Question: Write a descriptive caption for this figure.
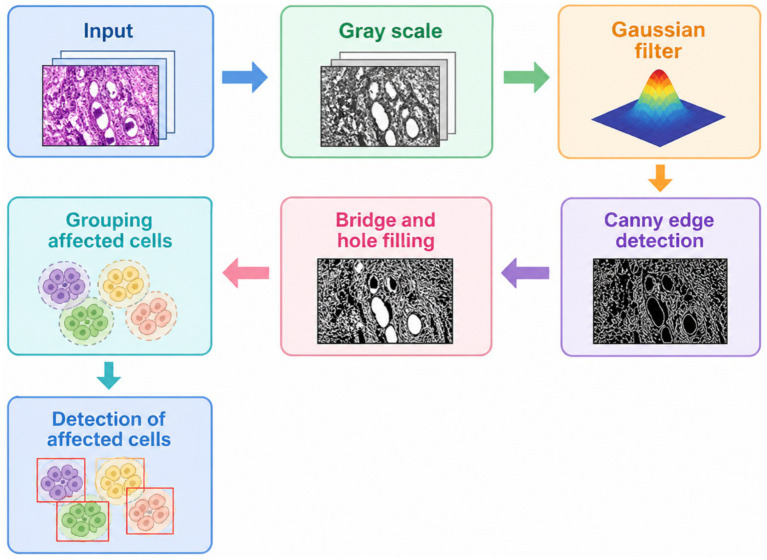
Answer: Steps involved in image preprocessing.